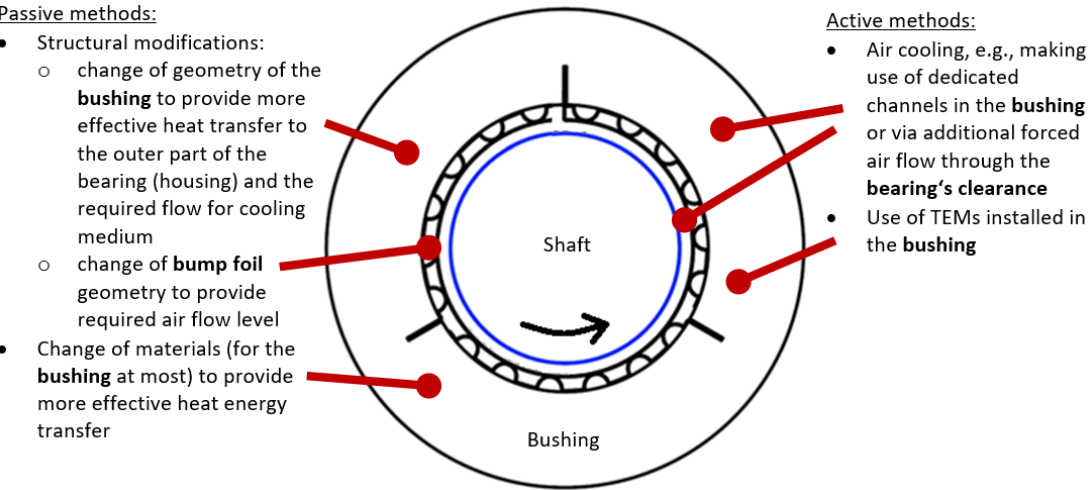
Figure 3. Thermal management in GFBs applied to enhance the performance of the bearings and prevent the loss of thermal stability. Heat energy source and sink components may be adequately installed to control the heat flow through the GFBs’ body and prevent from undesirable excessive temperature